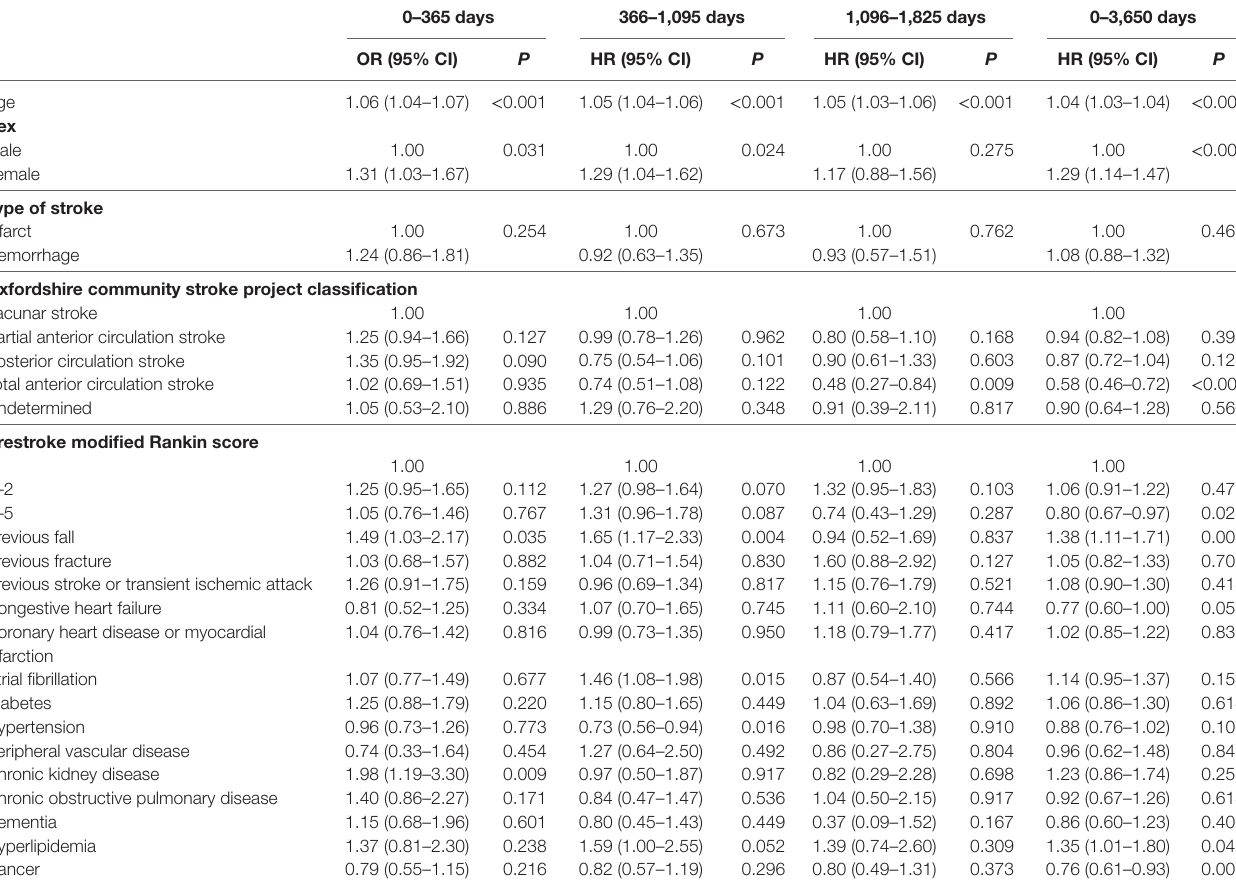
TaBle 3 | Multivariable analysis of risk factors for poststroke falls over time after